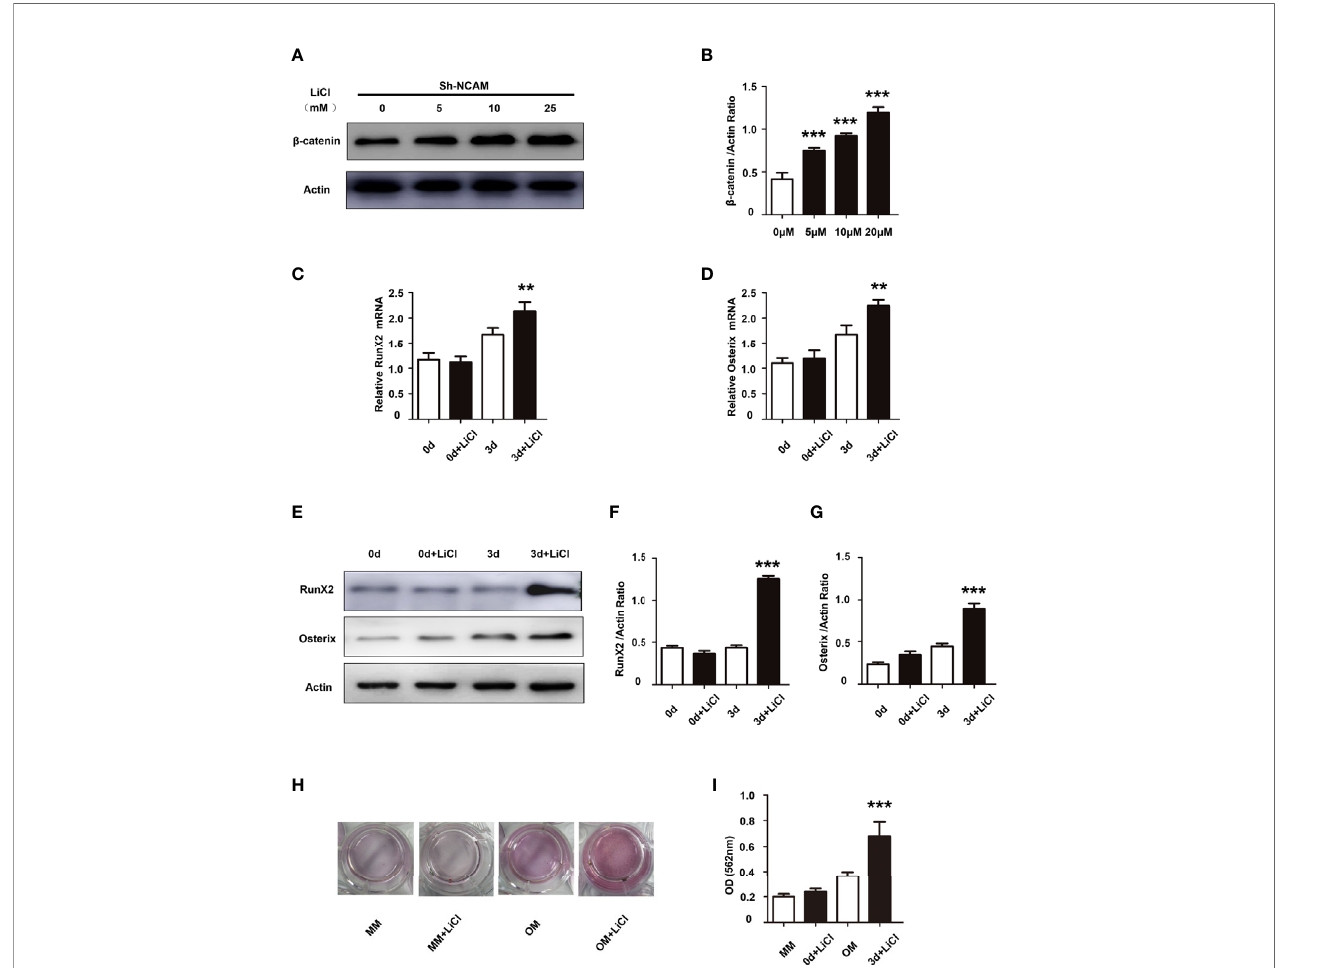
FIGURE 4 | Activation of Wnt/ b -catenin signaling recovers osteoblast differentiation inhibited by NCAM silencing. Sh-NCAM MC3T3-E1 cells were pretreated with the Wnt agonist LiCl. (A) the expression of b -catenin was analysed by immunoblotting at 0, 5, 10 and 25 min, b -actin was detected as a loading control. (B) Level of b - catenin was quanti fi ed by densitometry and normalized to b -actin (n=3; mean ± SEM; *** p < 0.001, compared with cells without LiCl). The expressions of (C) RunX2 and (D) Osterix were examined by real-time PCR (The results are expressed as the mean ± SEM of three independent experiments. ** p < 0.01, compared with cells without LiCl). (E) The expressions of RunX2 and Osterix were analysed by immunoblotting, b -actin was detected as a loading control. Levels of (F) RunX2 and (G) Osterix were quanti fi ed by densitometry and normalized to b -actin (Data are representative of three independent experiments and values are means ± SEM. *** p < 0.001, compared with cells without LiCl). (H) Calcium deposition was assessed by Alizarin red staining. (I) The Alizarin red staining was extracted and quanti fi ed, the wavelength was measured at 562 nm (Data are representative of three independent experiments and values are means ± SEM. *** p < 0.001, compared with cells without